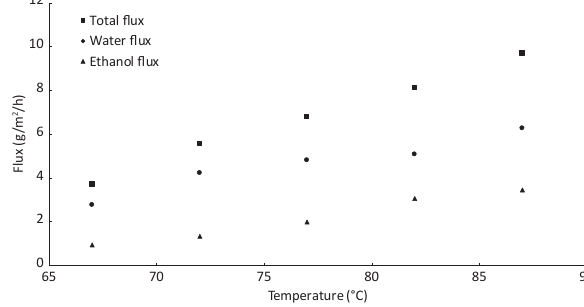
Figure 7: Influence of temperature on the flux for ethanol-water solution with 0.33 %wt of